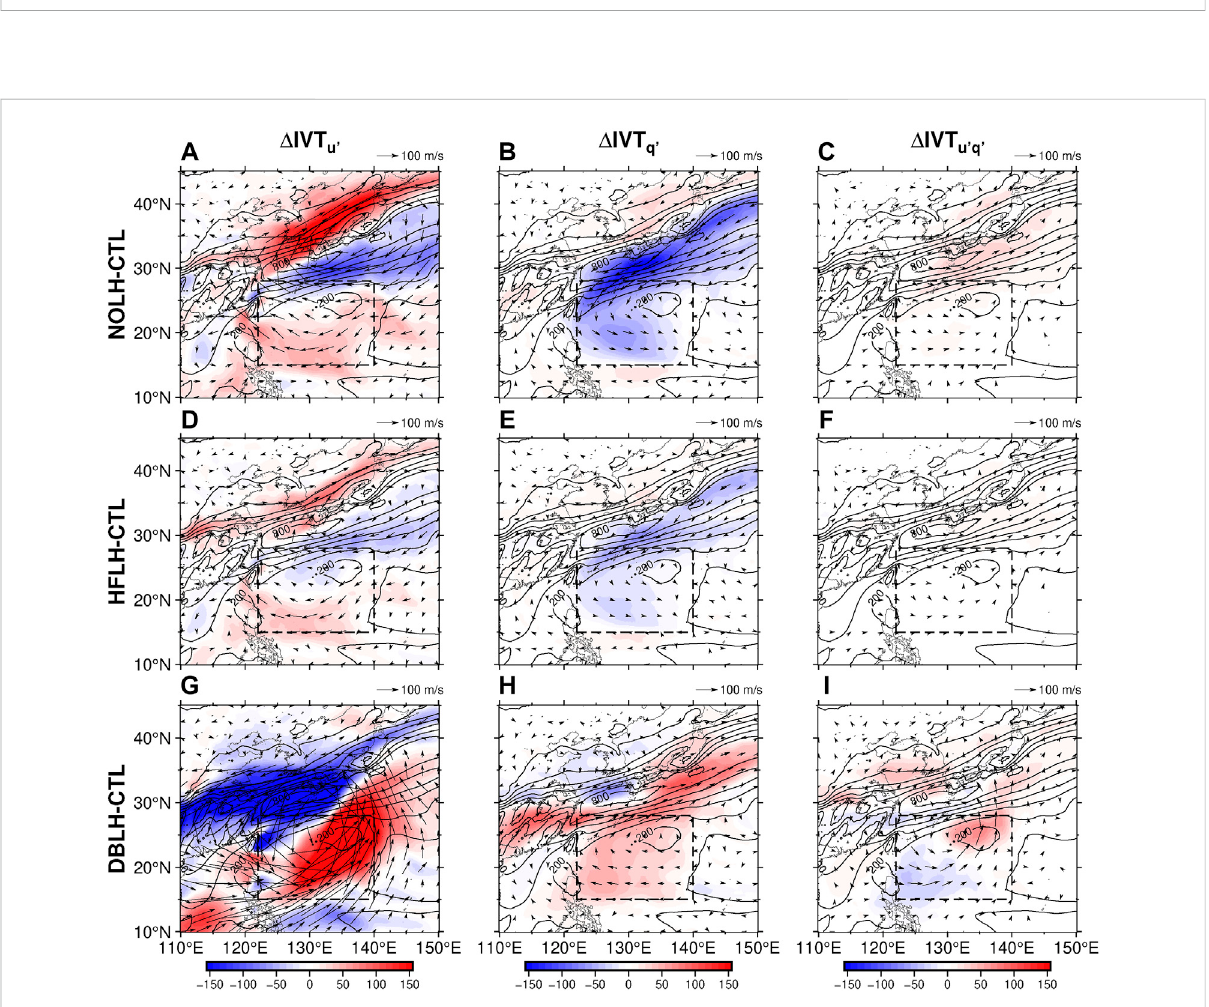
FIGURE 7 Contributions of wind ( Δ IVT u ′ ), moisture ( Δ IVT q ′ ), and the eddy term ( Δ IVT u ′ q ′ ) in moisture transport (IVT). Contoursrepresent the IVT in the CTL run (every 200 kg/m/s), and dashed boxes show the subtropical WP region.